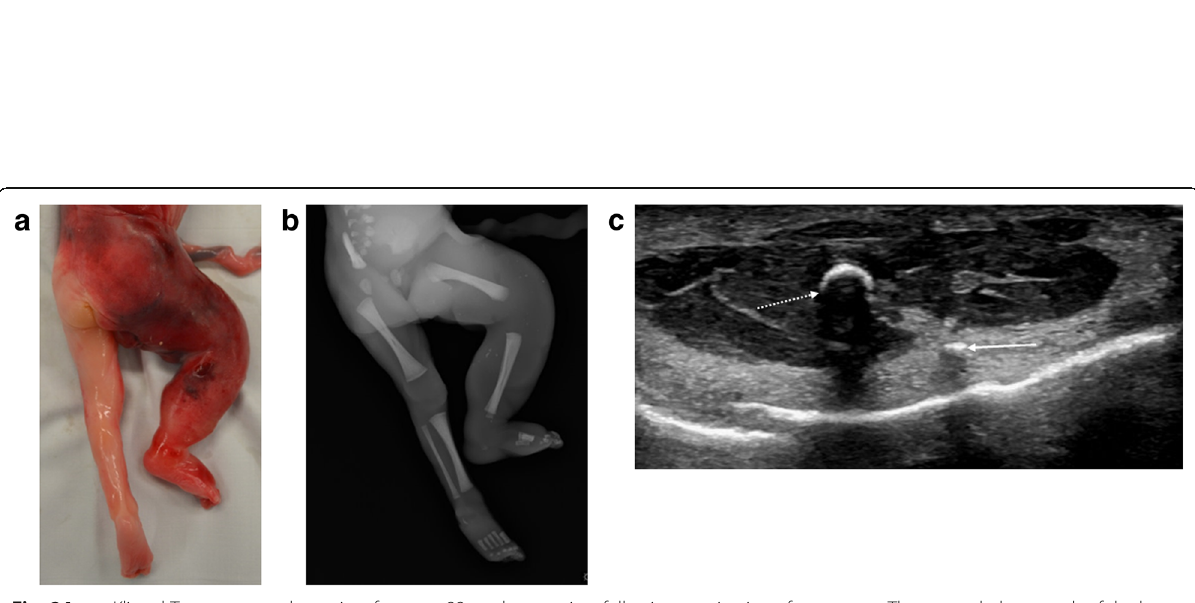
Fig. 24 a – c Klippel-Trenaunay syndrome in a foetus at 22weeks gestation, following termination of pregnancy. The external photograph of the lower limbs at autopsy ( a ), seen from behind, reveals an enlarged right leg with discoloured red and purple overlying skin. The post-mortem lateral radiograph of this right limb ( b ) reveals numerous small hyperdense foci within the soft tissues which are tiny phleboliths. At post-mortem ultrasound of the right thigh ( c ), obtained in axial plane 1day after delivery, the small phleboliths were well seen with posterior acoustic shadowing. One of these is demonstrated with a solid arrow, the dotted arrow represents the right femur. At autopsy, extensive ectatic thin-walled vessels containing thrombus were seen in the right leg and in keeping with a vascular malformation. Due to lack of circulation and small diameter of vessels, this vascular anomaly could not be well depicted on